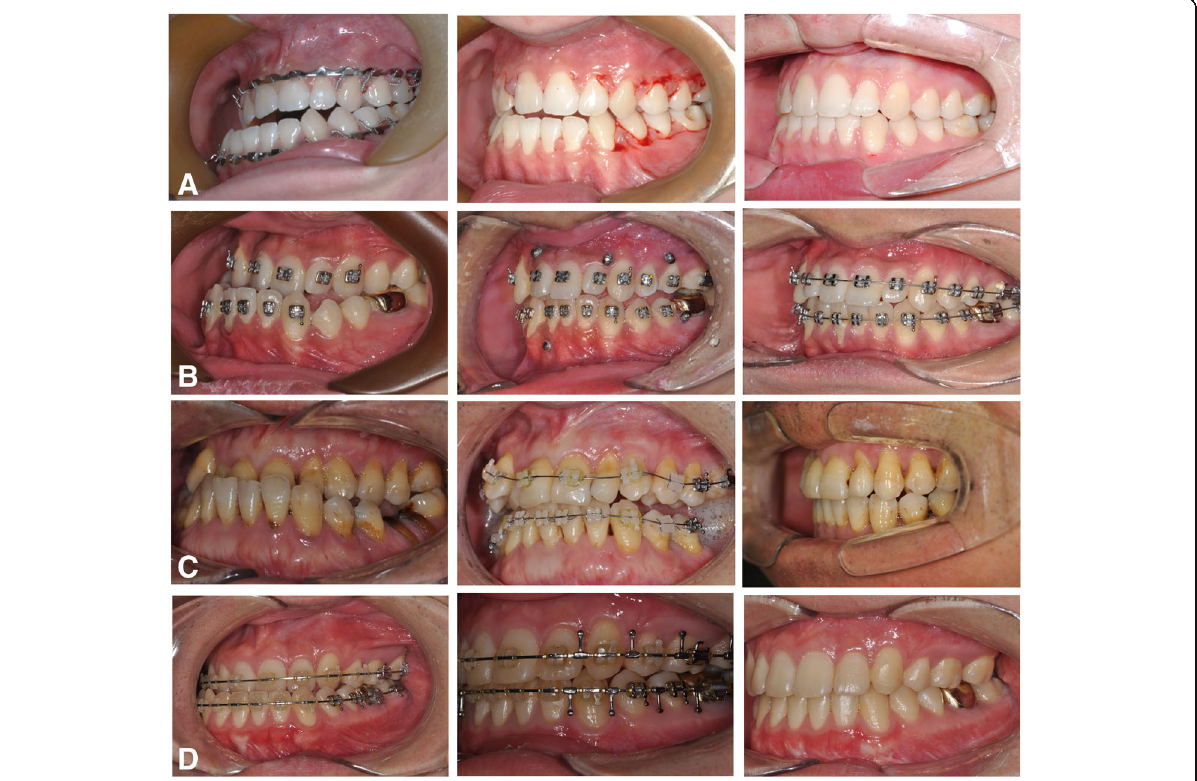
Fig. 5 Presurgical orthodontic preparations for the SFA ( a , b , c ) versus the conventional approach ( d ). Arch bars ( a ), brackets with maxillomandibular anchor screws without archwire ( b ), or light rectangular stainless steel wires are frequently used in the SFA, whereas strong rectangular surgical wires with surgical hooks are commonly used in the conventional approach ( d ). Photos located in the left column, before surgery; middle column, immediately after surgery; right column, at the time of